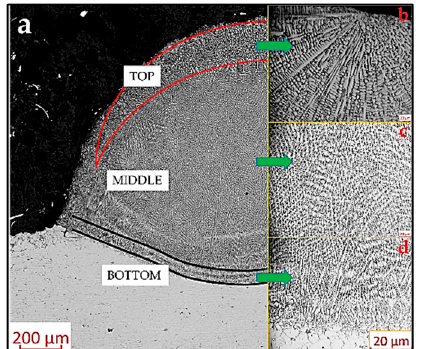
Figure 6. ( a ) A typical morphology of a deposit; magnified images of ( b ) top; ( c ) middle; ( d ) bottom regions of the bead.